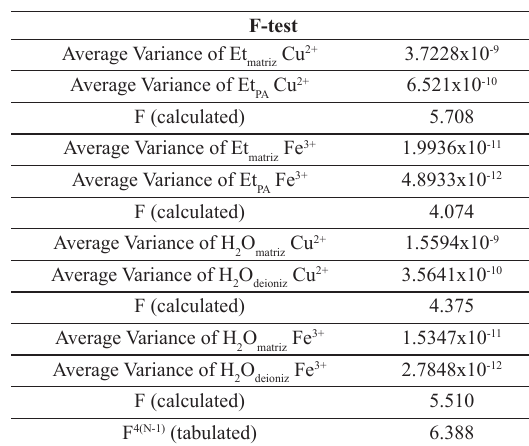
Table 2. F-test for the study of selectivity in aqueous and ethanolic medium for BDD